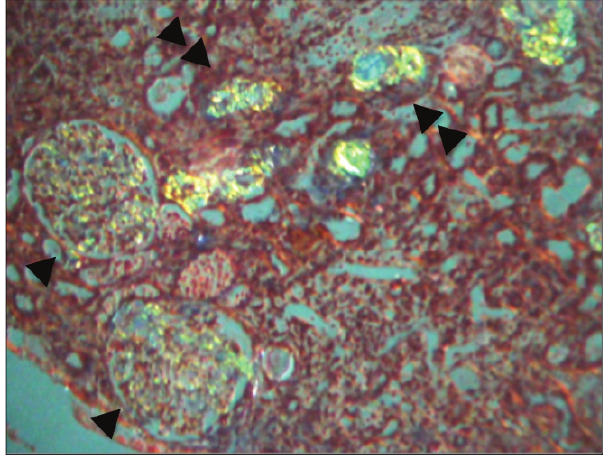
Figure 2 - Congo red staining shows apple-green birefringence on glomeruli ( arrowheads ) and tubules ( double arrowheads ). Not shown: tubules with degenerative changes, focal areas of necrosis and areas of interstitial nephritis. Normal blood vessels.